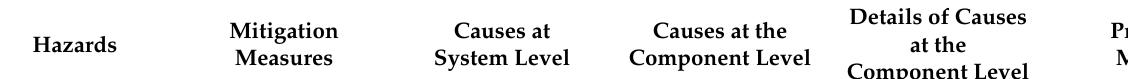
Table 2. Hazard and risk analysis (extracted sample of various spread